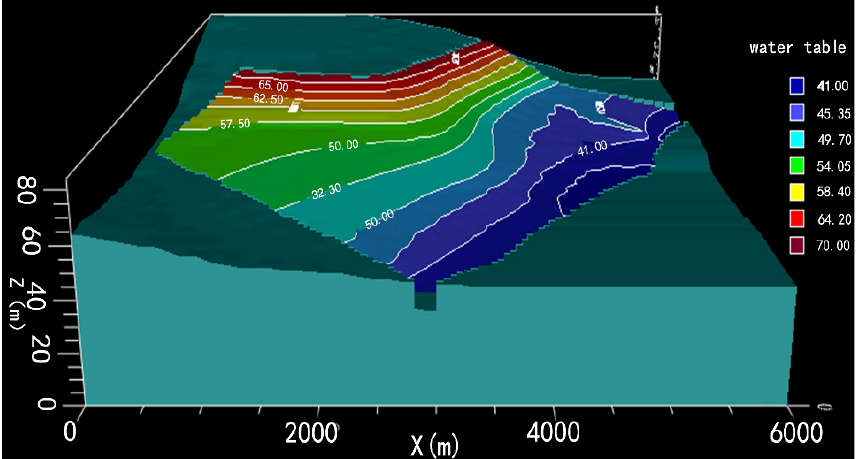
Figure 5. Simulation result of the groundwater contour (in meters).